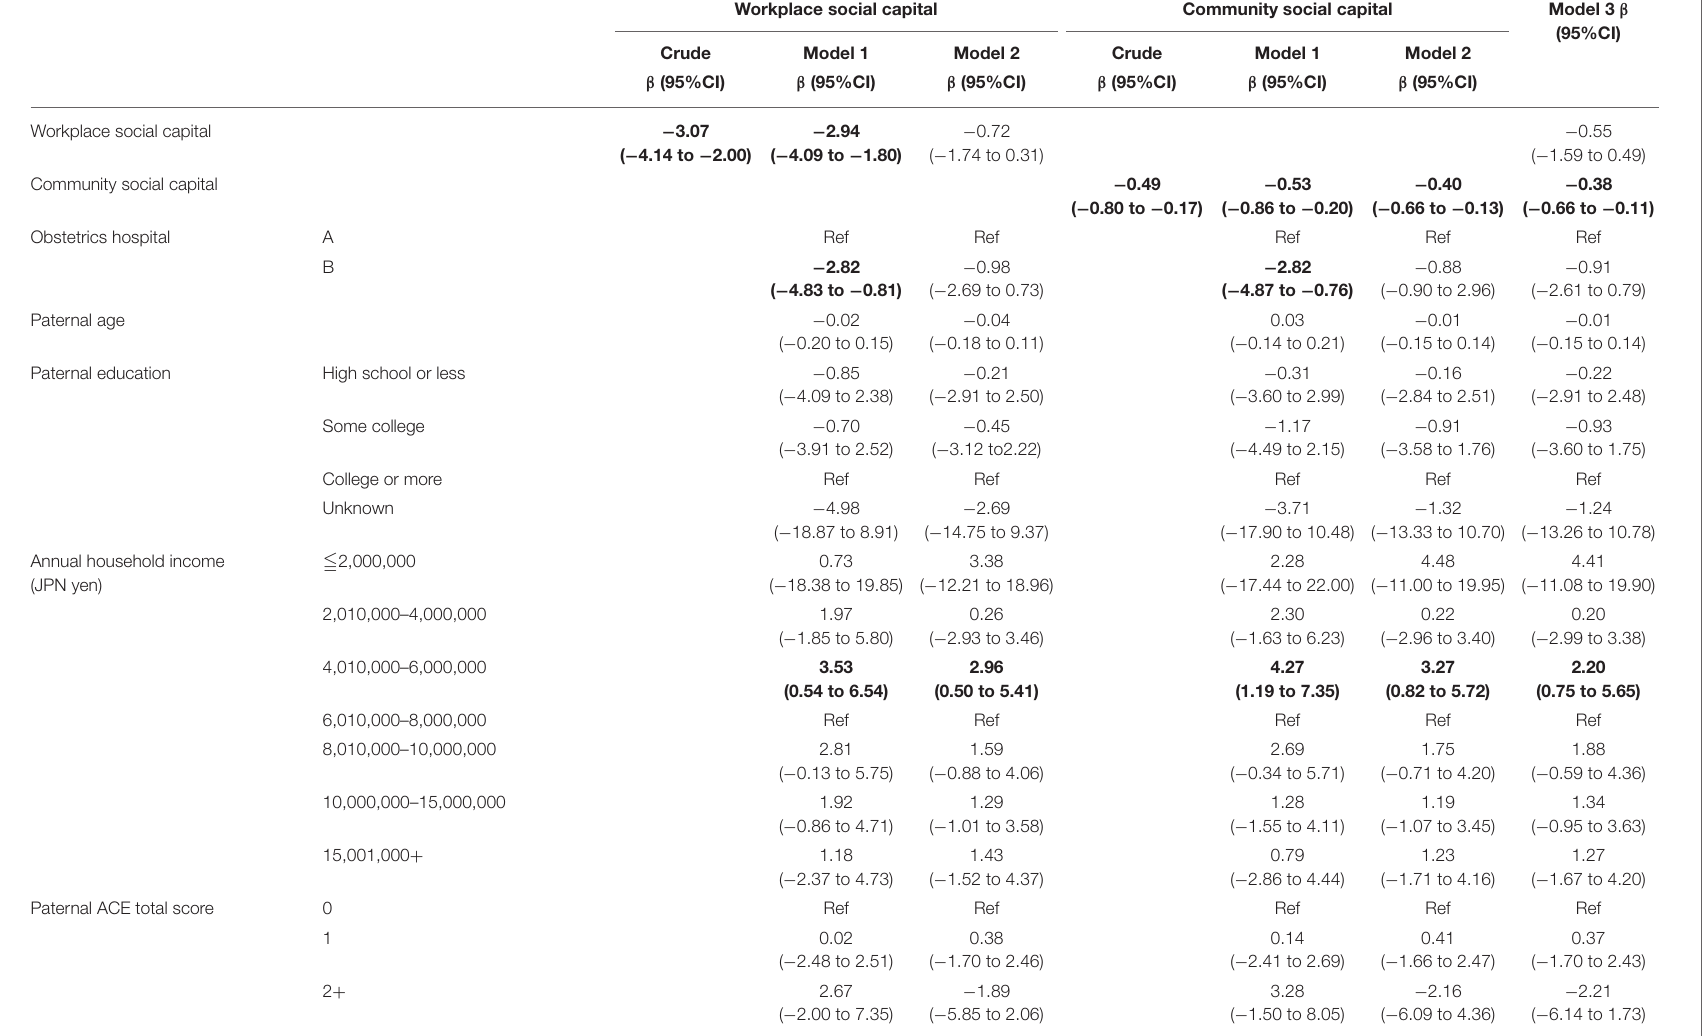
TABLE 4 | Association between paternal social capital and paternal anxiety at 3 months after delivery after multiple